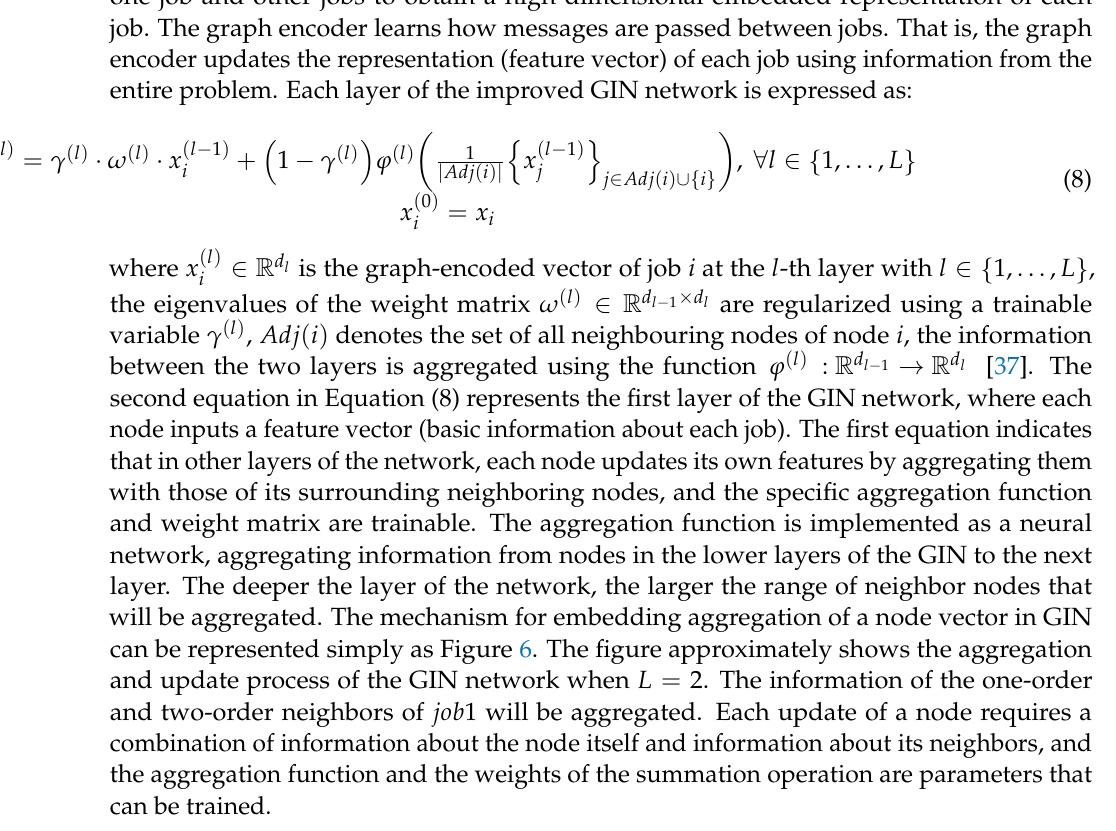
Figure 5. A complete graph representation of the PFSP problem. Originally proposed by [34], GNNs extend the existing neural network models to process data from graphs or topological structures, and have achieved good performance in graph node classification, regression problems, and other fields. In the proposed network structure, job context information is obtained by encoding all job nodes through a graph isomorphic network (GIN) [35,36]. GIN is utilized to learn the context information between one job and other jobs to obtain a high-dimensional embedded representation of each job. The graph encoder learns how messages are passed between jobs. That is, the graph encoder updates the representation (feature vector) of each job using information from the entire problem. Each layer of the improved GIN network is expressed as: